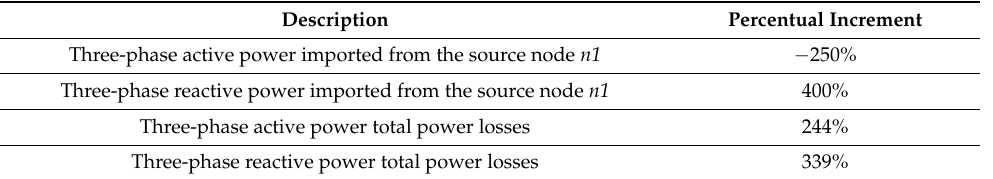
Table 5. Effect of the integration of the PRO plants on the three-phase active and reactive power flow and system